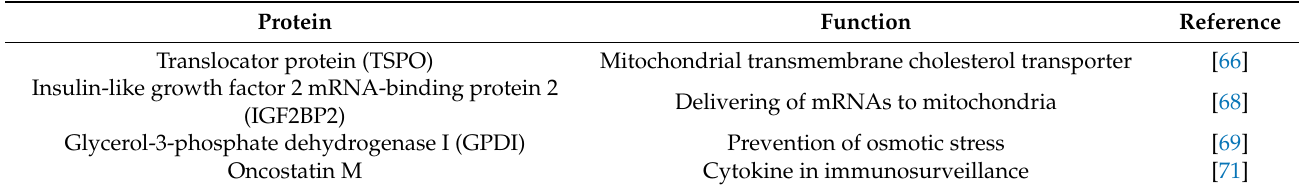
Table 1. Proteins that are involved in oxidative phosphorylation (OXPHOS) in glioblastoma stem cells (GSCs) as potential selective therapeutic targets. Protein Function Reference